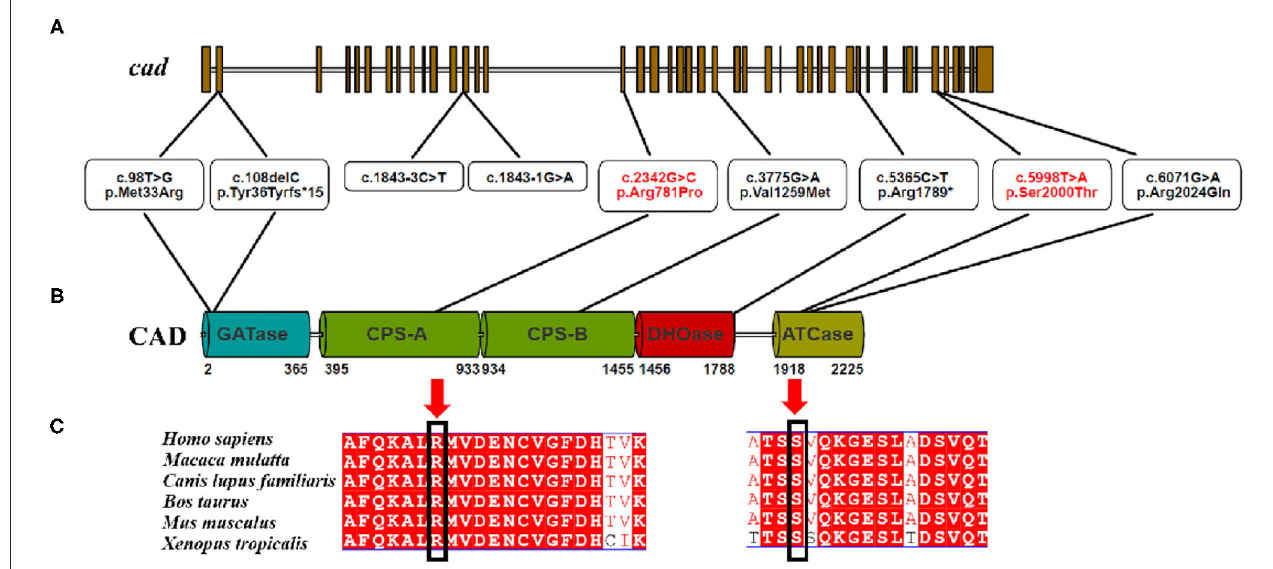
FIGURE 3 | (A–C) CAD is evolutionally conserved among different